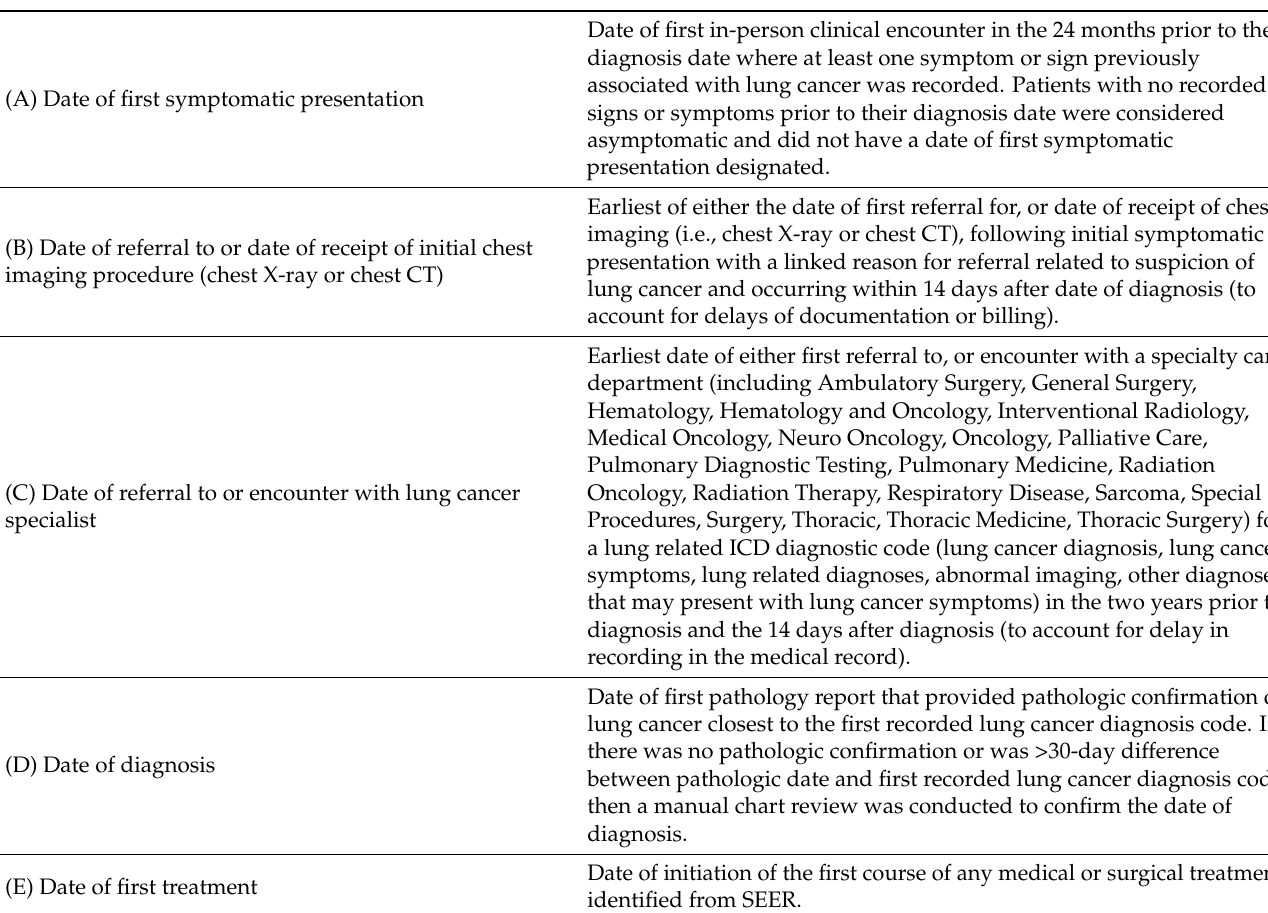
Table A1. Definitions of timepoints from first presentation to initiation of treatment for lung